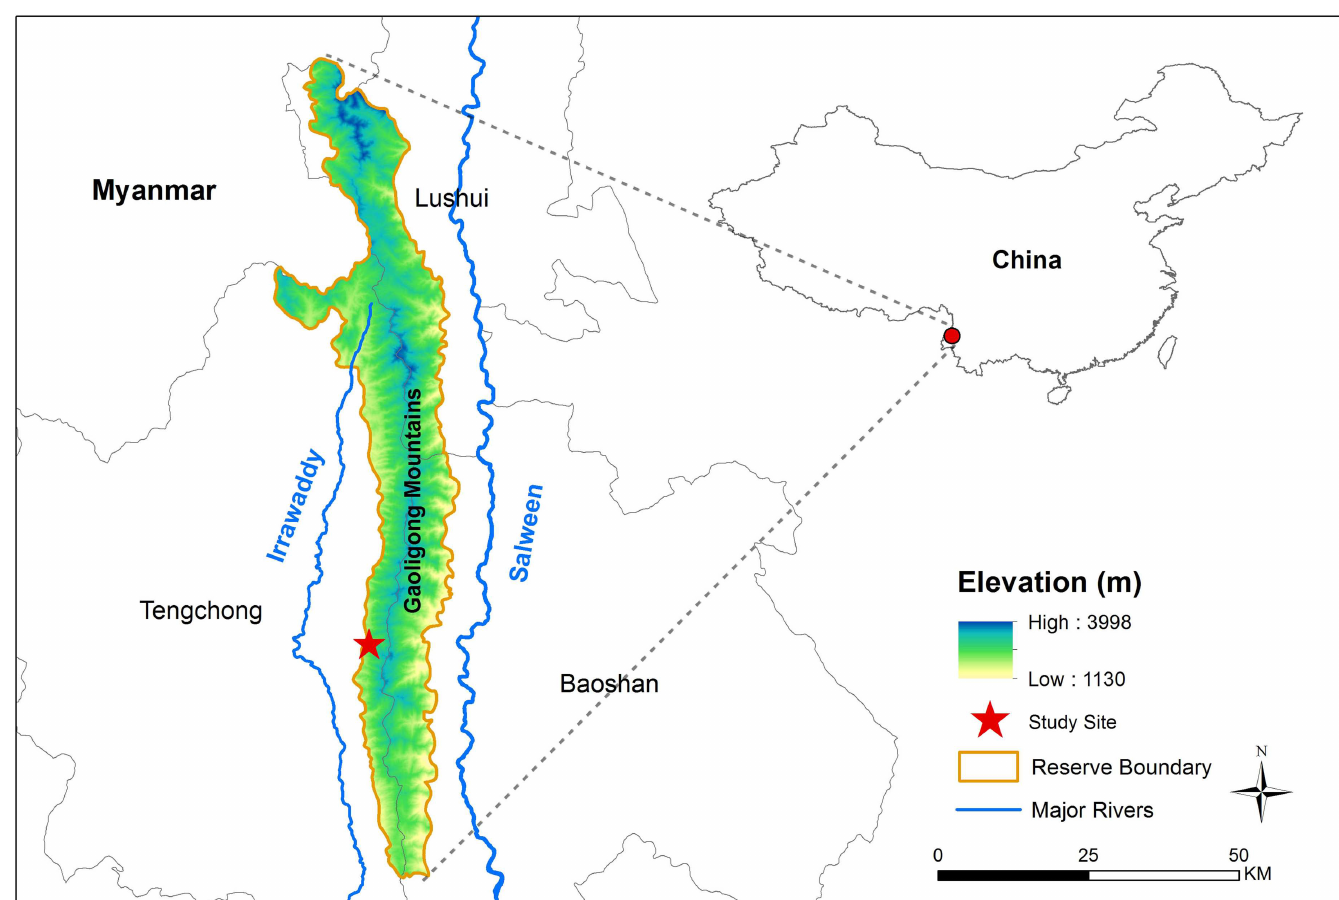
Fig 1. Map of the study site in the Gaoligong Mountains Nature Reserve(southern part) in Yunnan Province, Southwest